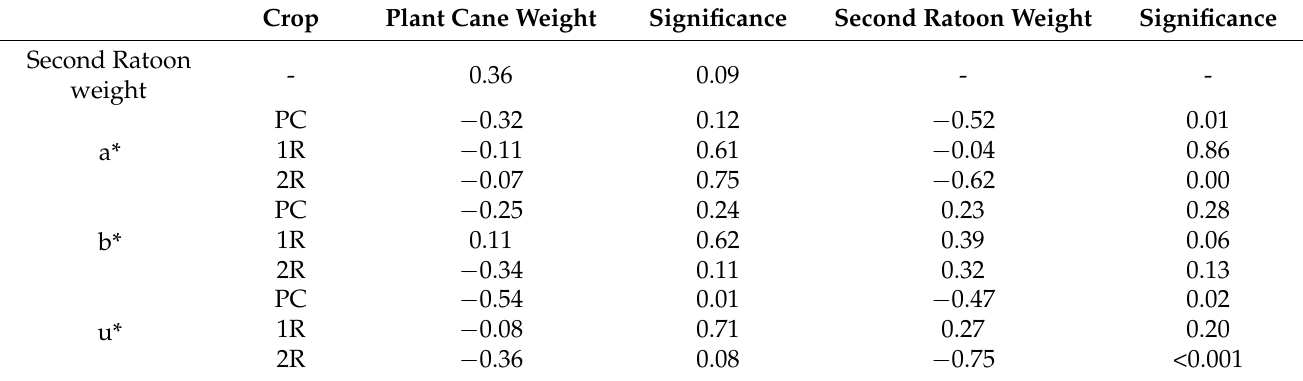
Table 4. Correlations (Pearson) of remote sensing RGB CIELab indices to sugarcane family plot cane weight. Crop Plant Cane Weight Significance Second Ratoon Weight